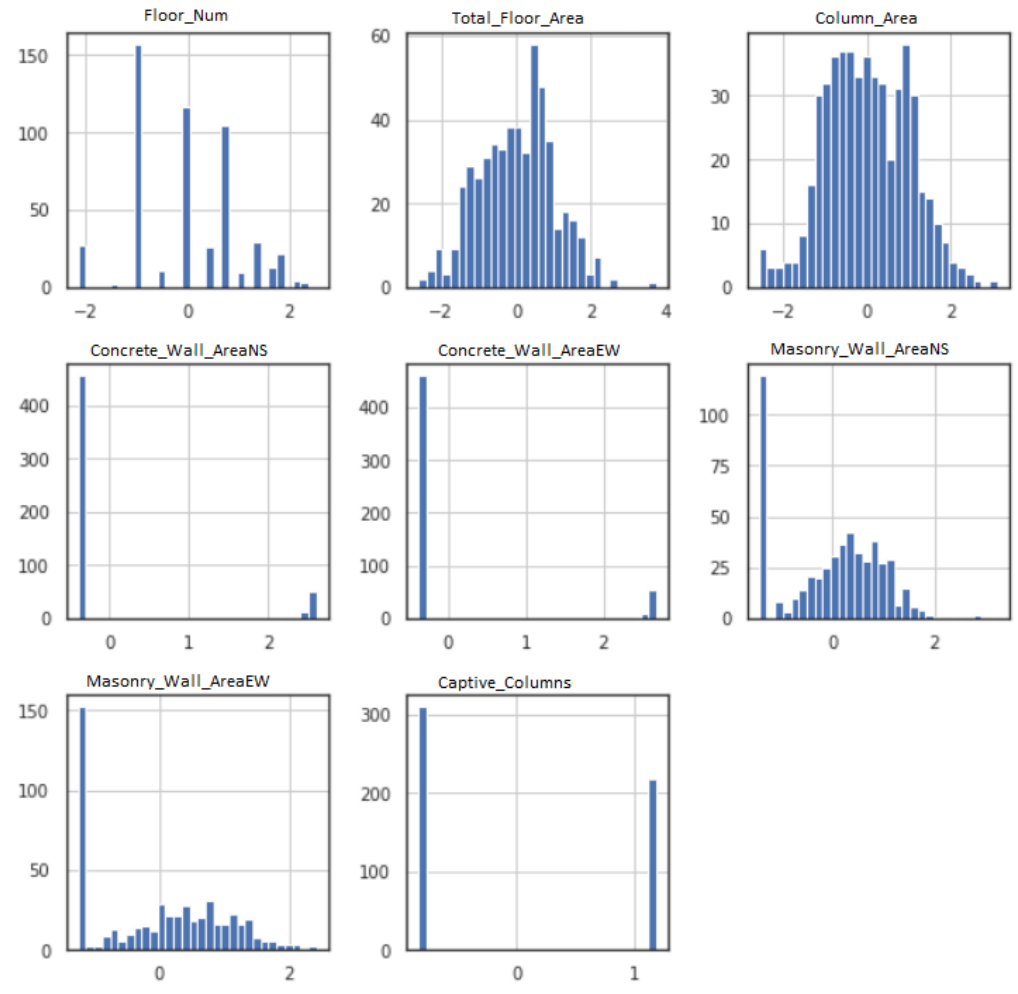
Figure 3. Distribution of data on each input variable after employing PowerTransformer.